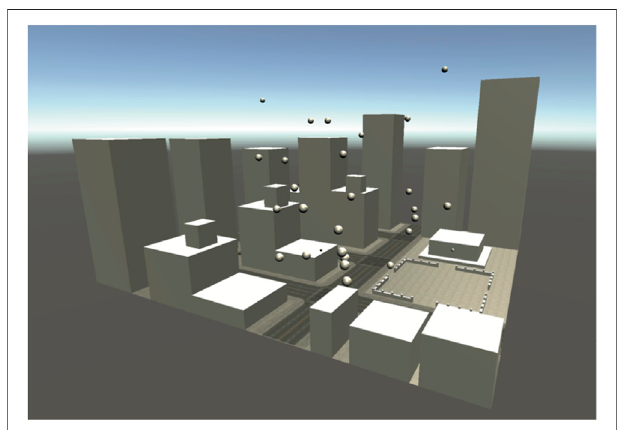
FIGURE 2 | Simulated urban environment: obstacle view.